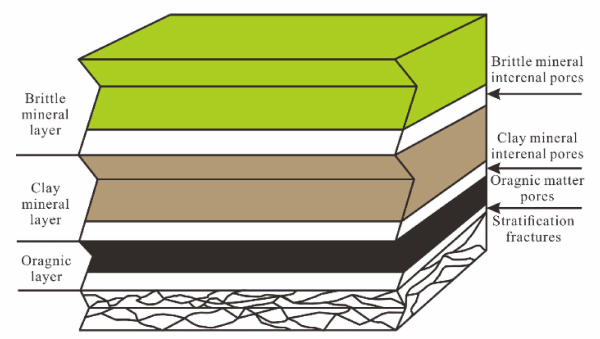
Figure 2. Physical layered model of the shale rock